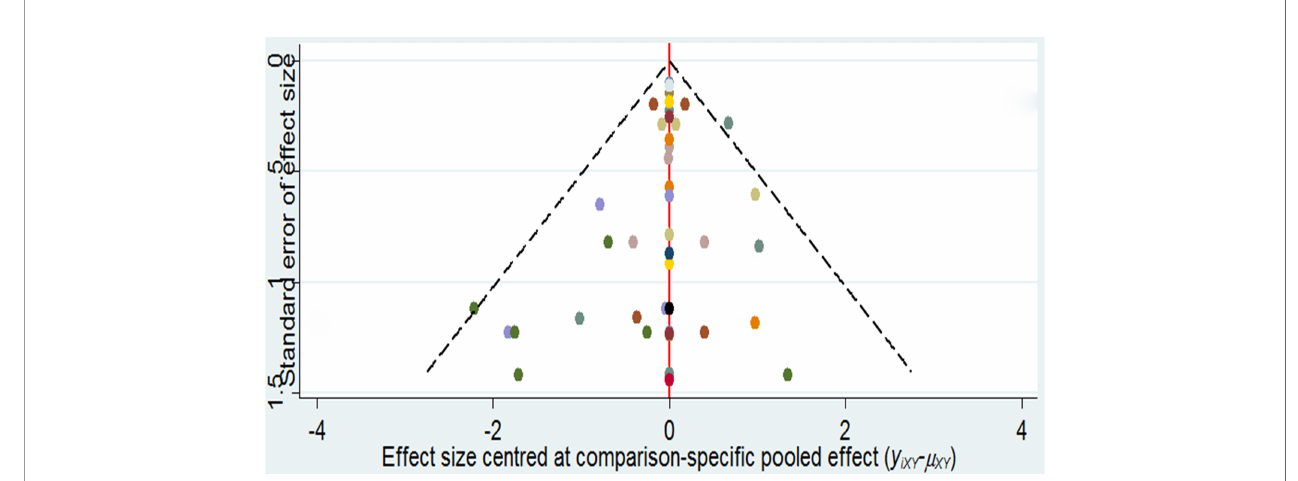
FIGURE 3 | Comparison-adjusted funnel plots of the network.